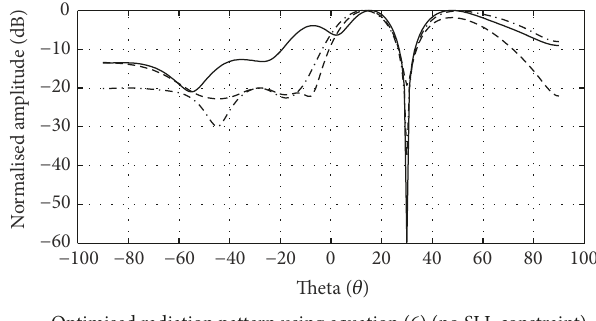
Figure 6: Radiation patterns for BDRA array before and after the optimisation using (6) and (7) for Case I in the presence of mutual coupling.